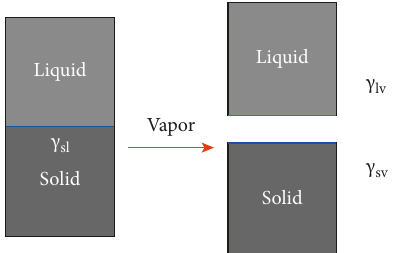
Figure 4: Schematic diagram of the two-phase